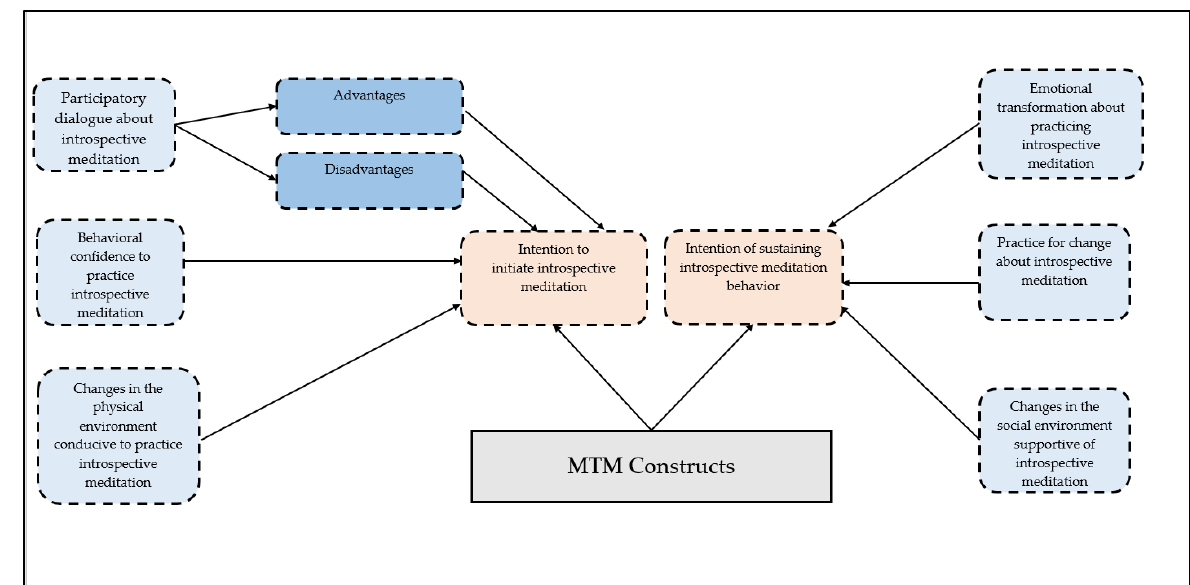
Figure 1. Multi-level theory framework. Figure 1. Multi-theory model